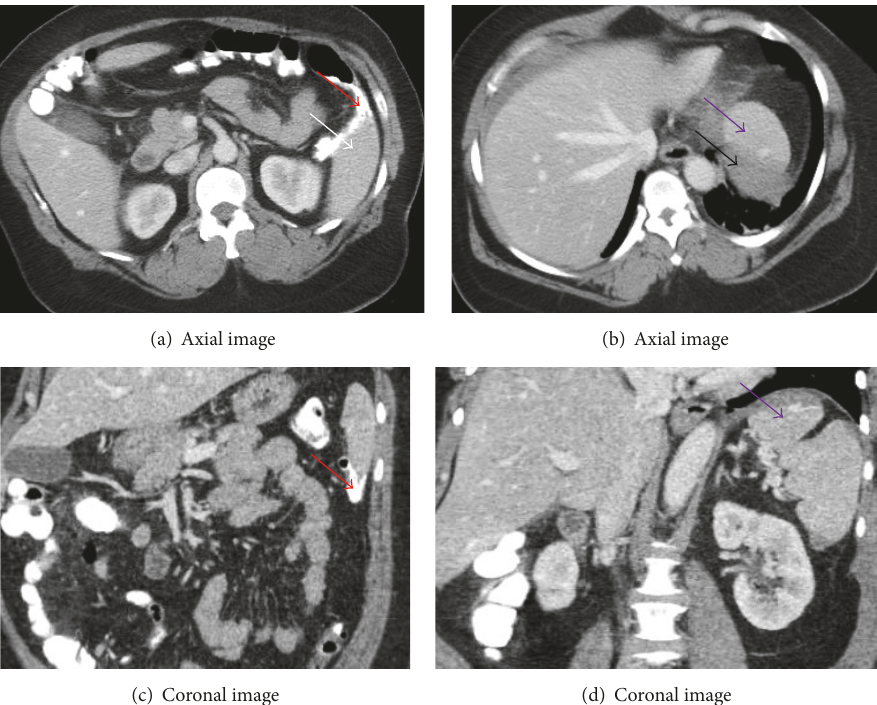
Figure 1: CT, 05/05/17: perisplenic and subcapsular hematoma (black arrow) along the dome of the spleen, with an area of active bleeding along the superior subcapsular region (purple arrows) with no clear fat plane separation between the colonic splenic flexure and the lower portion of the spleen (white arrows) and contrast tracking irregularly along diverticula/splenocolic adhesions and splenocolic ligament (red